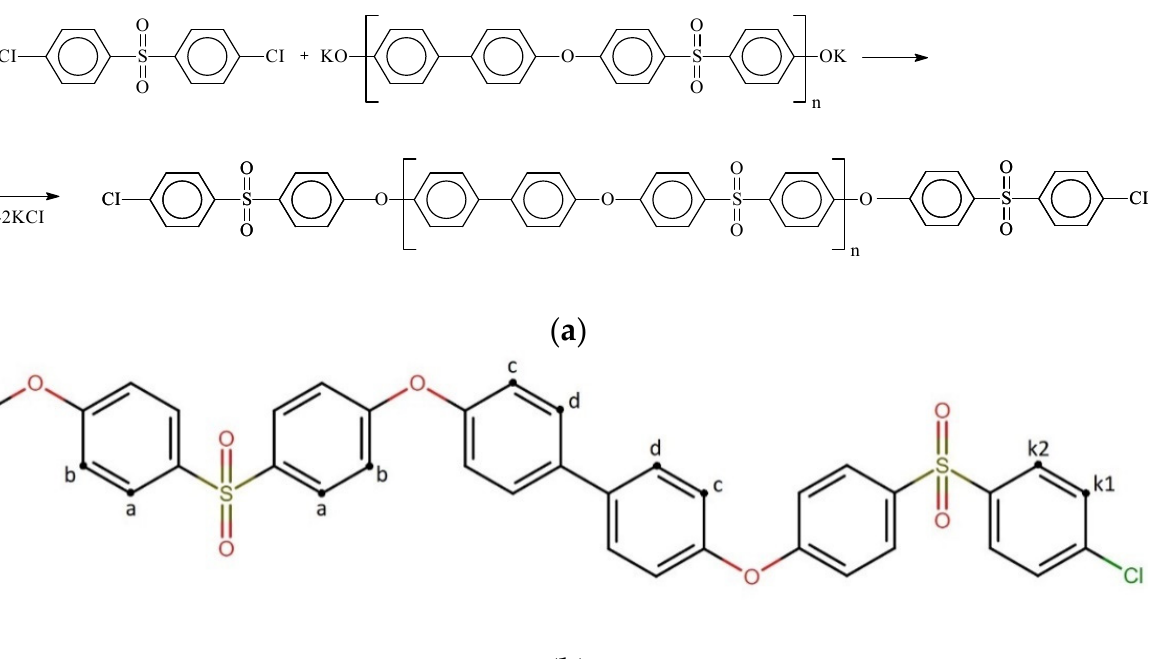
Figure 1. Scheme for the synthesis of PPSU ( a ), structure of the terminal fragment of the PPSU polymer chain ( b ).